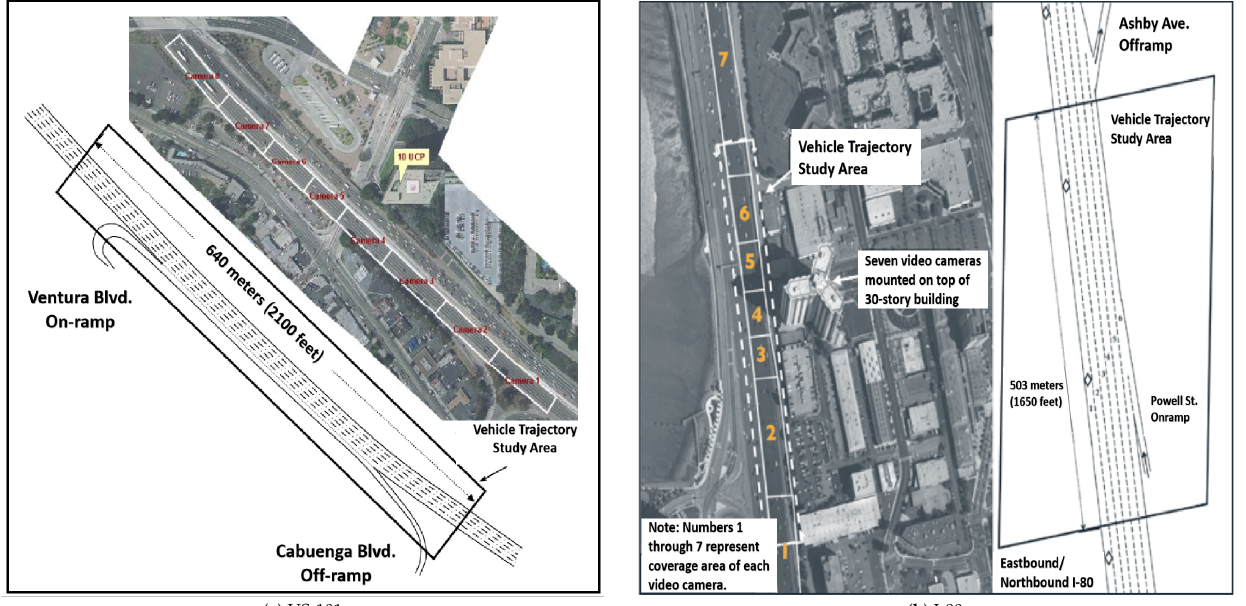
Figure 5. Scenarios of NGSIM datasets